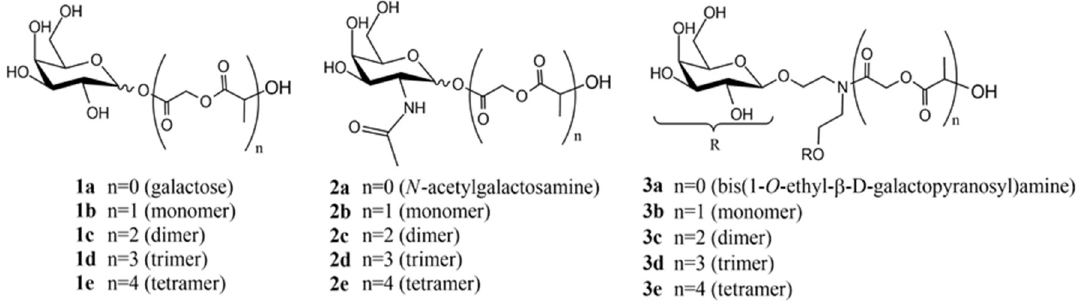
Figure 1. Ligands chemical structures used for the docking studies.